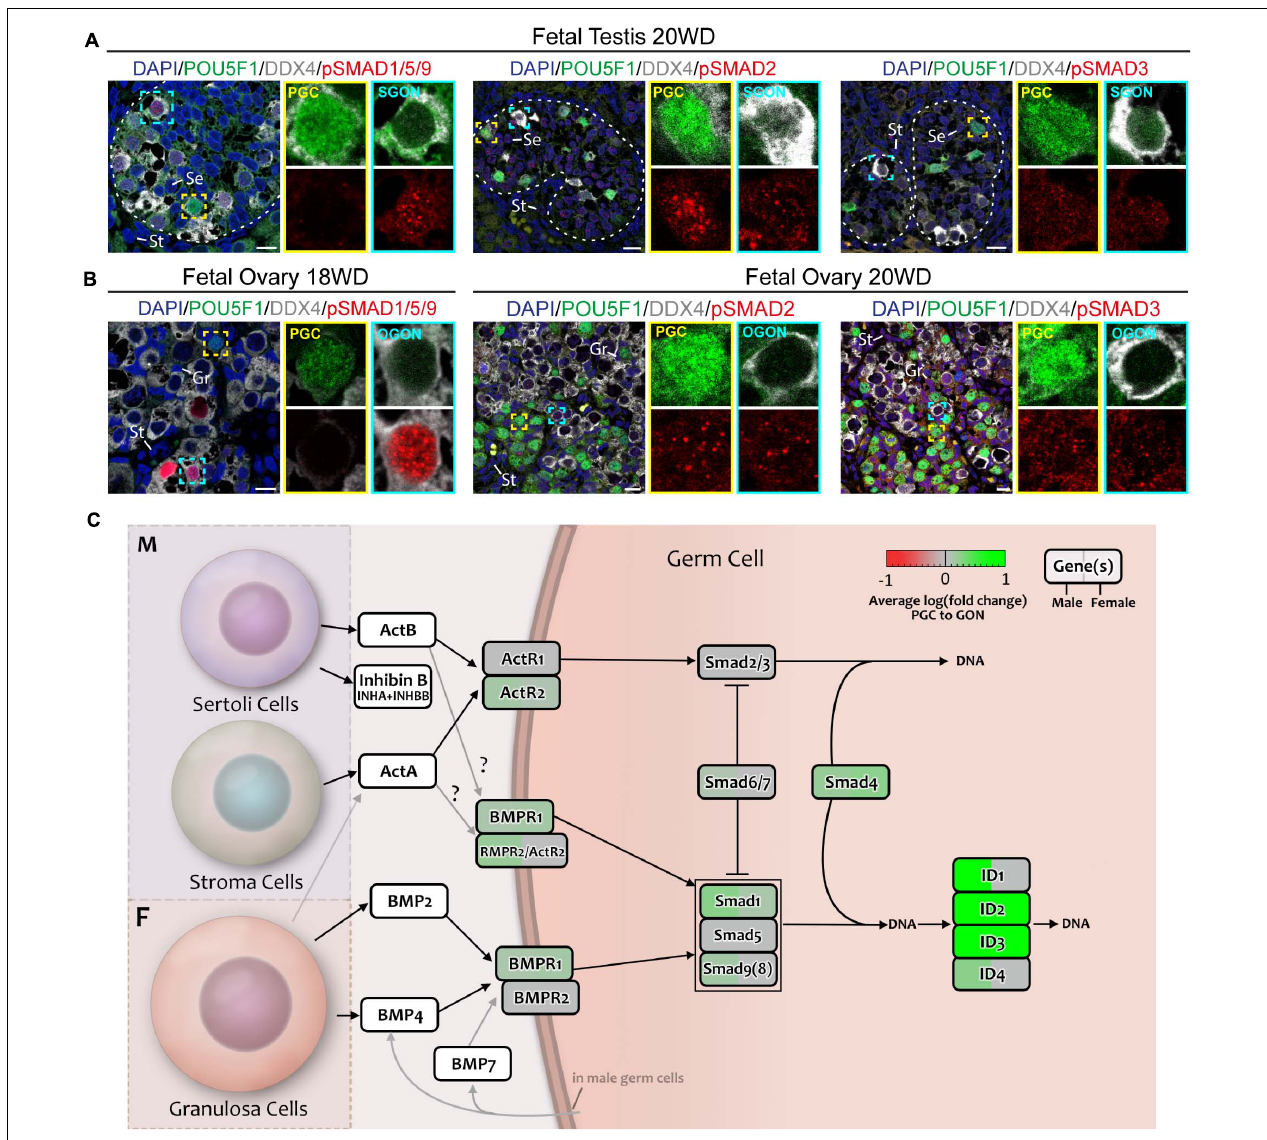
FIGURE 8 | Analysis of TGF β /BMP signaling in fetal gonads by immunostaining for key (phosphorylated) pathway effectors. (A,B) Immunofluorescence of phosphorylated (p)-SMAD1/5/9 and pSMAD2/3 with DDX4 and POU5F1 in fetal testis of 20 WD (A) and fetal ovary of 18 WD (B) . In the testis, pSMAD1/5/9 is localized in SGONs, whereas in the ovary, it is localized to a subset of OGONs. In contrast, pSMAD2 and 3 are present in all cell types of both the ovary and testis. Yellow boxes indicate zoom-in of a PGC, and cyan boxes indicate zoom-in of a GON. Se, St, and Gr annotate Sertoli, stromal, and granulosa cells, respectively. Scale bar indicates 10 µ m. (C) A schematic model of active signaling BMP/TGF β axes in germ cells representing a combination of results from CellphoneDB analysis and differentially expressed gene analysis. Genes upregulated in GONs are depicted in green, while those upregulated in PGCs are depicted in